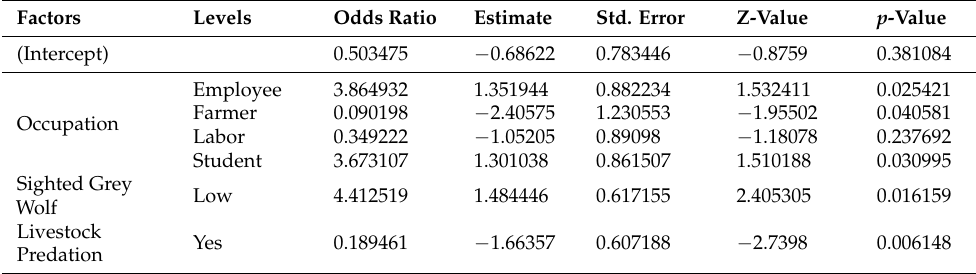
Table 4. The effect of significant socio-economic factors on the attitude of locals towards the wolf. The estimates are the GLM-based effects, which are translated by logs as odds ratio (standard error). The significance of each level compared to a level (called reference level) is presented by p -values, which are further supported by z-values.